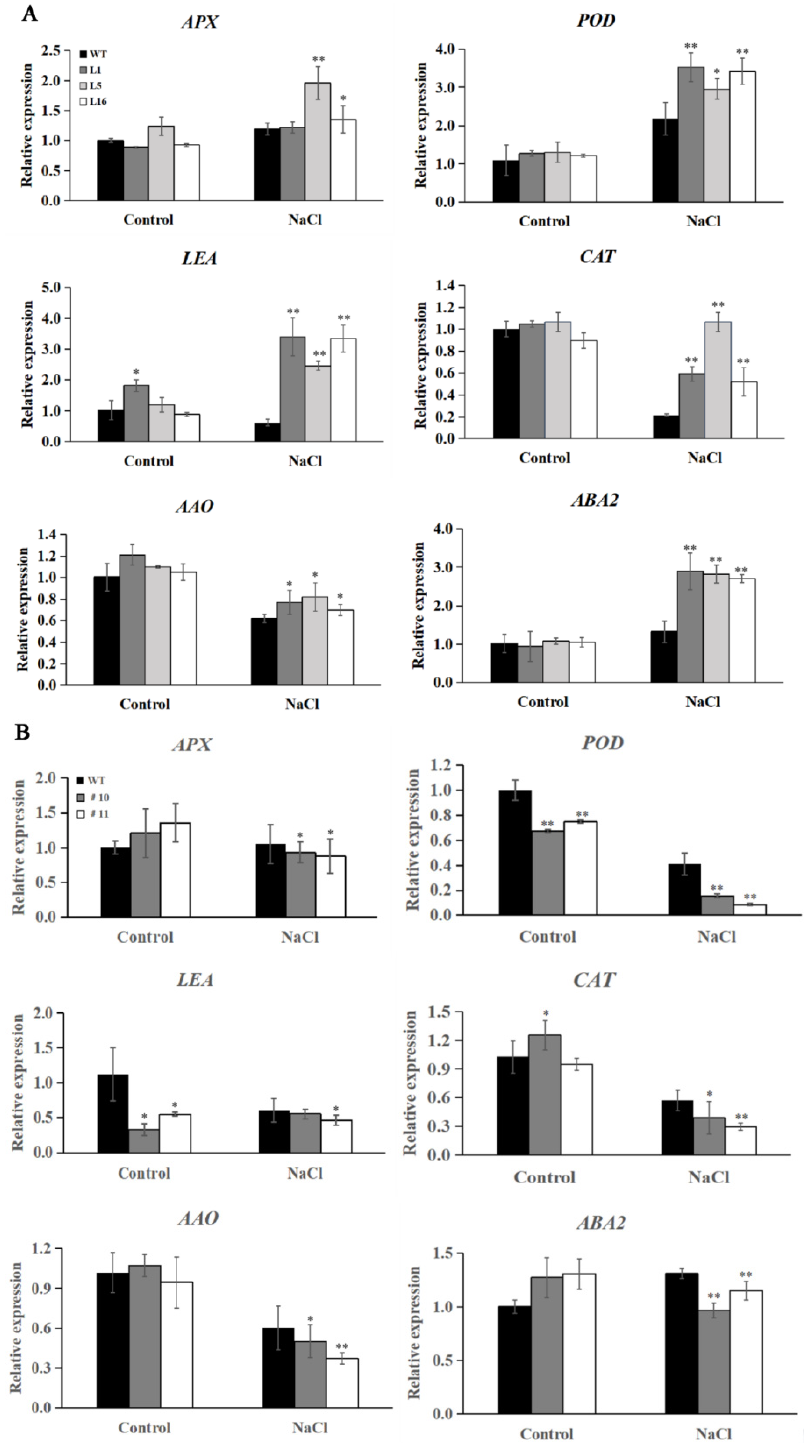
Figure 6. Expression levels of stress-responsive genes in transgenic and WT sweet potato plants. ( A ) Expression patterns of stress-related genes in the WT and the overexpressed transgenic lines L1, L5, and L16. ( B ) Expression patterns of stress-related genes in the WT and the RNAi transgenic lines #10, #11. Plants grown in the transplanting boxes were sampled for analysis after treating with no stress (normal) for 12 h and salt stress for 12 h. Data are presented as means ± SE ( n = 3). ** and * indicate significant differences between the transgenic lines and WT at p < 0.01 and p < 0.05 levels, respectively.